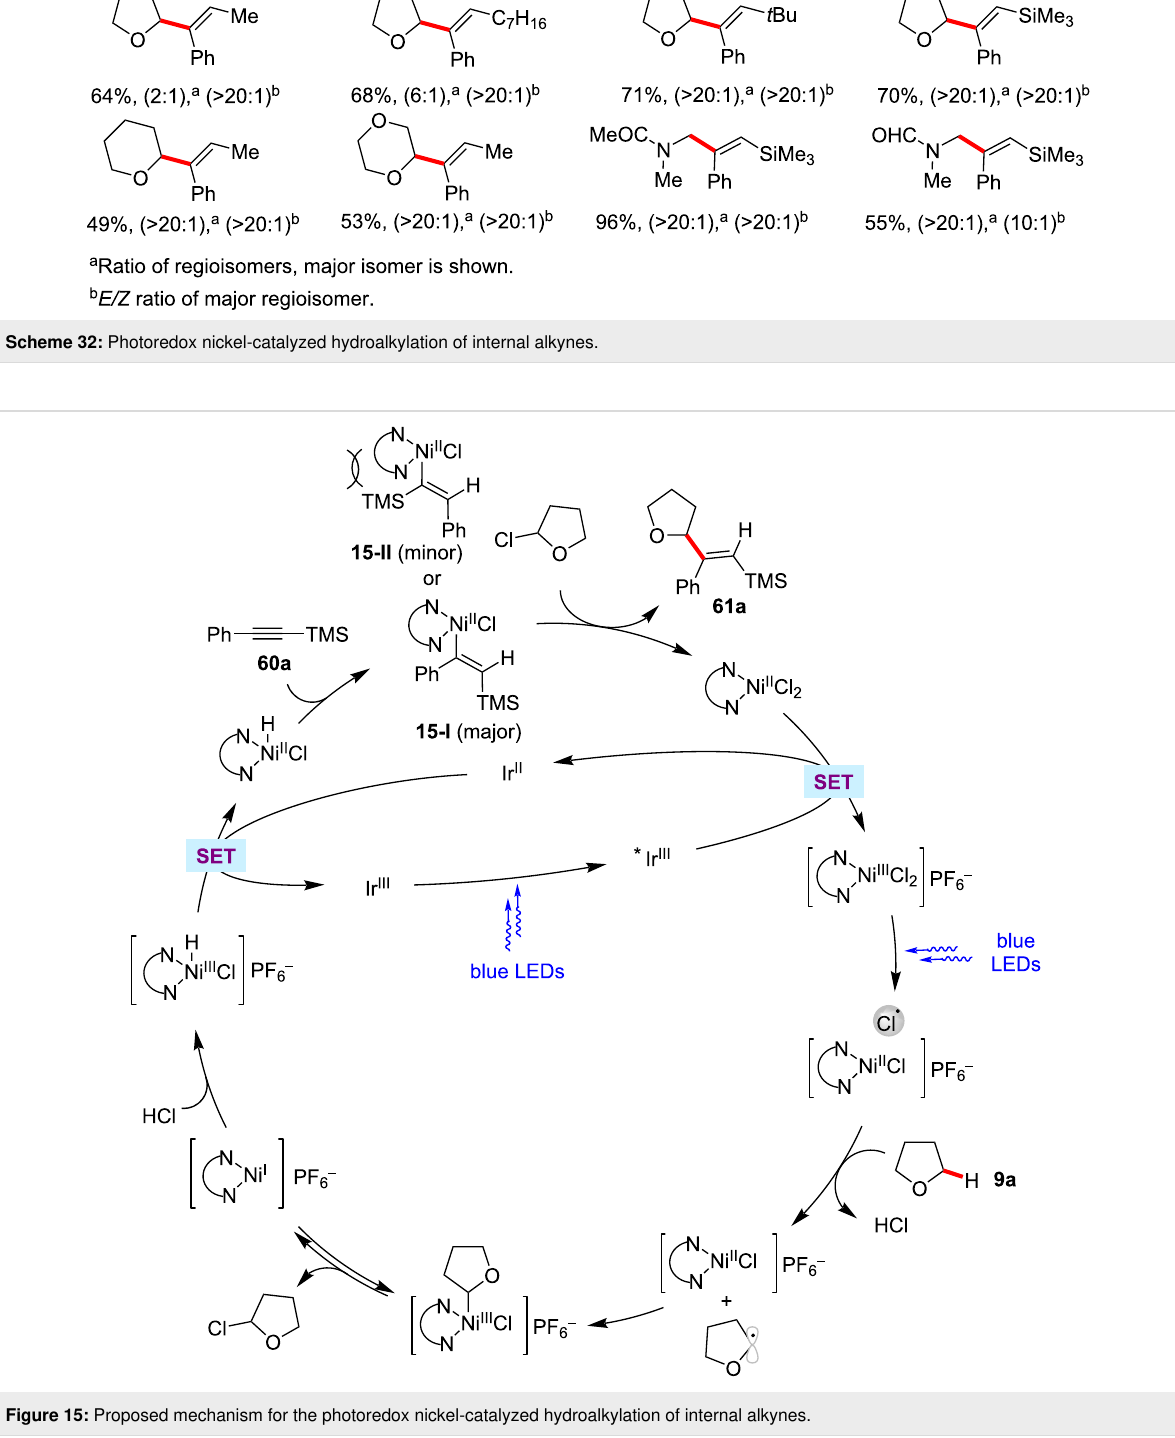
Figure 15: Proposed mechanism for the photoredox nickel-catalyzed hydroalkylation of internal